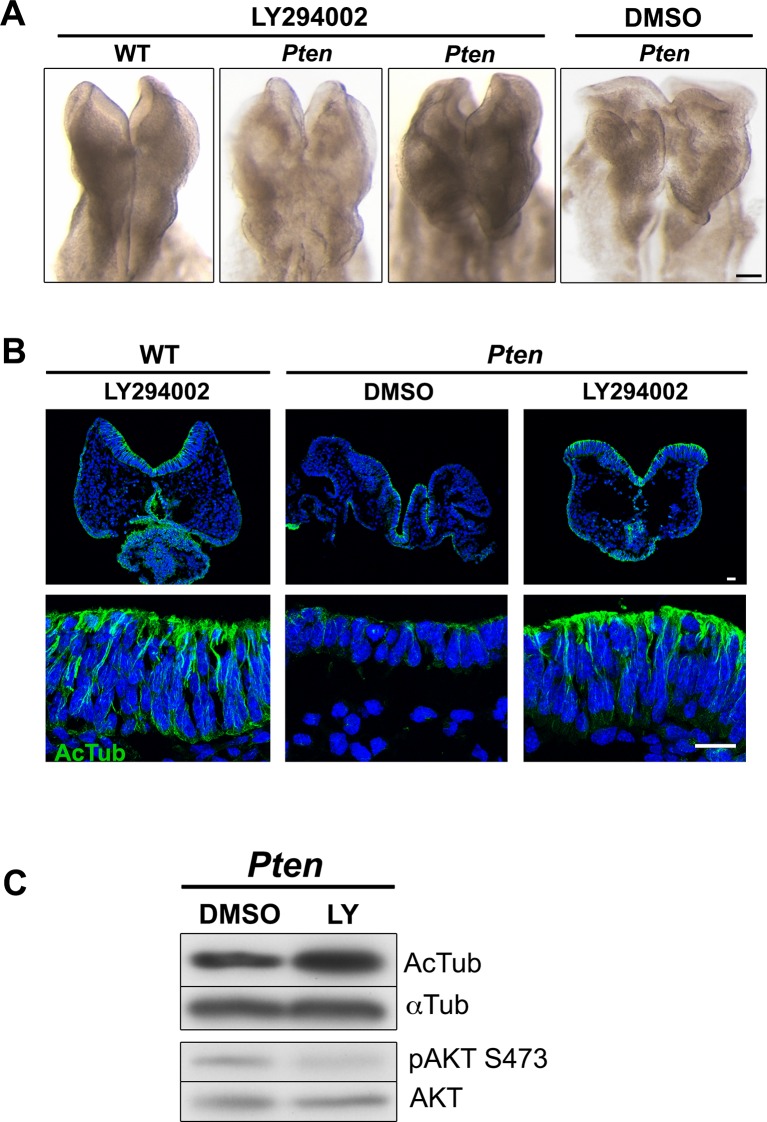
Inhibition of PI3 kinase restores pseudostratification in the Pten △Epi neural plate.(A) Mothers of Pten △Epi mutant embryos were injected with 25 mg/kg of LY294002 24 hr prior to E8.5 embryo dissection. This treatment leads to elevation of the neural folds and prevents the formation of abnormal folds in the Pten △Epi neural plate phenotype without affecting wild-type development. (B) Immunostaining for acetylated tubulin (green) of transverse sections of the cephalic neuroepithelium of treated E8.5 WT and Pten △Epi embryos. Blue is DAPI. (C) Western blot analysis of untreated and LY294002-treated Pten mutant embryos shows an increase in tubulin acetylation and inhibition of phosphorylation of AKT at Ser473, indicating that the treatment effectively inhibited PtdIns(3,4,5)P3 production. Scale bar in A = 120 μm; in B = 20 μm.